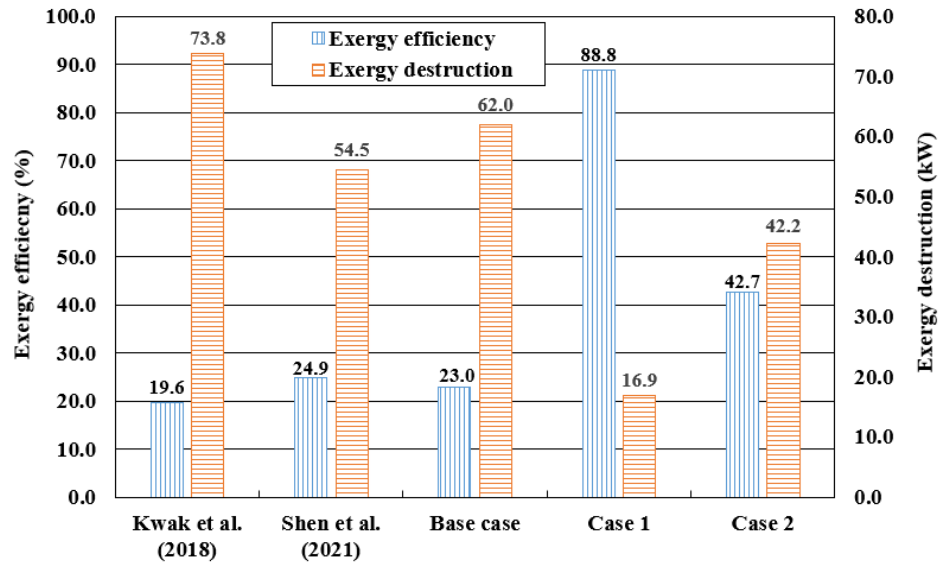
Figure 14. Exergy efficiency and exergy destruction of the BOG re-liquefaction systems [4,25].